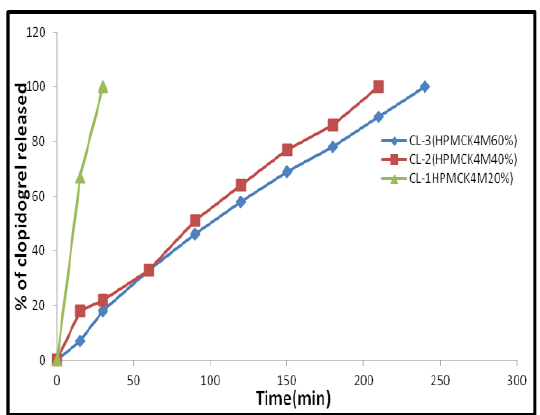
Figure2: Effect of HPMCK4M concentration on the release of clopidogrel in 0.1 N HCl and 37˚C.